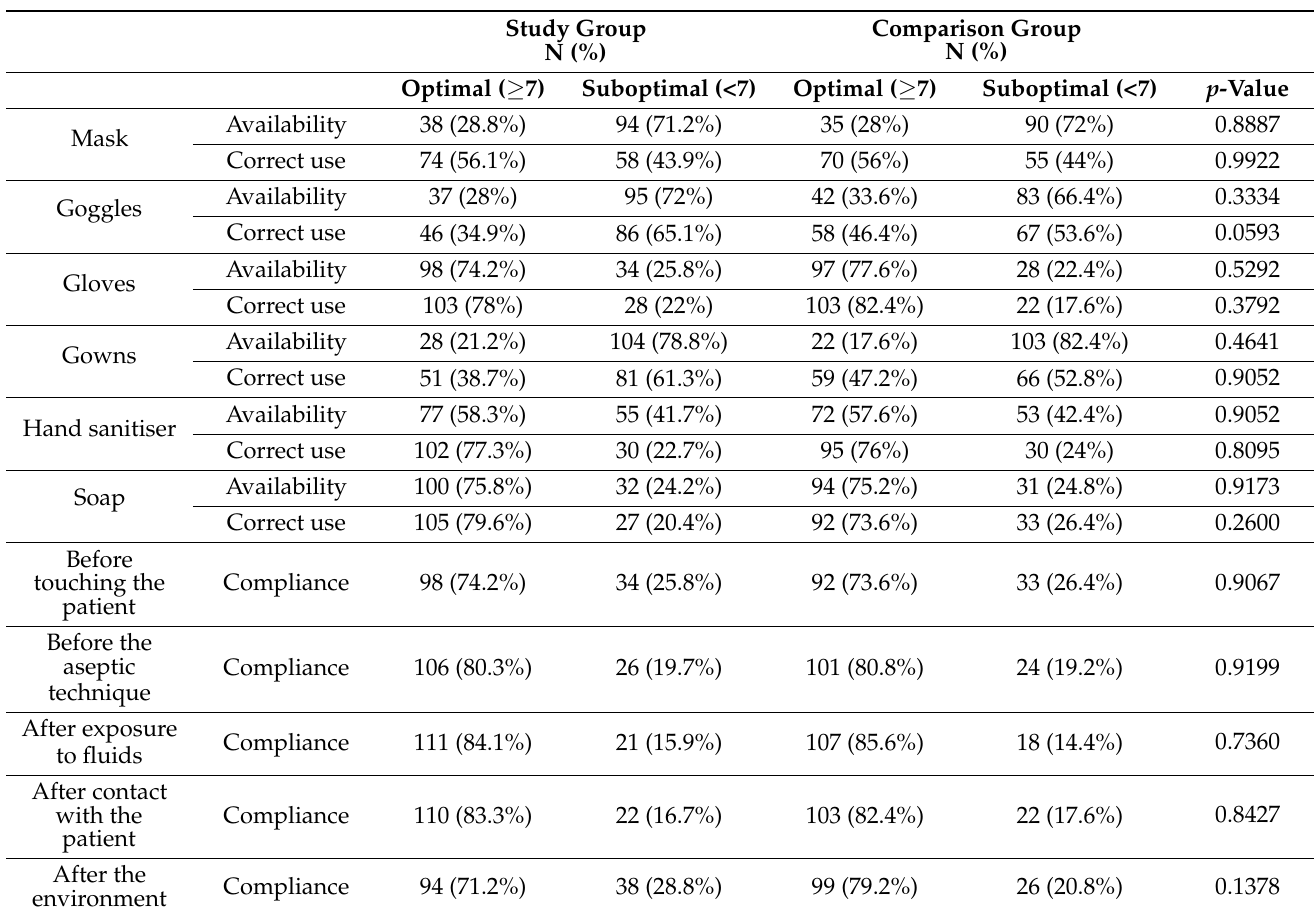
Table 4. Degree of availability and proper use of personal protective equipment (PPE) and hand hygiene products and